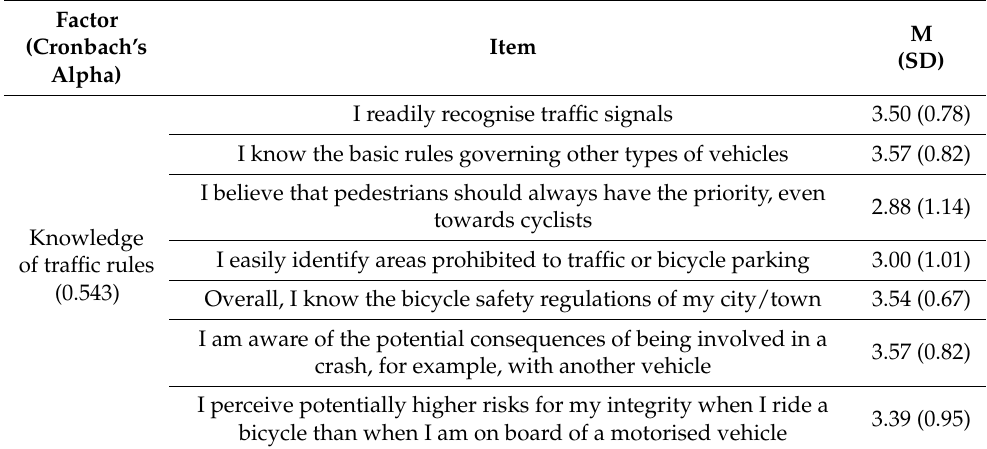
Table 2. Cyclist Risk Perception and Regulation Scale (RPRS) item